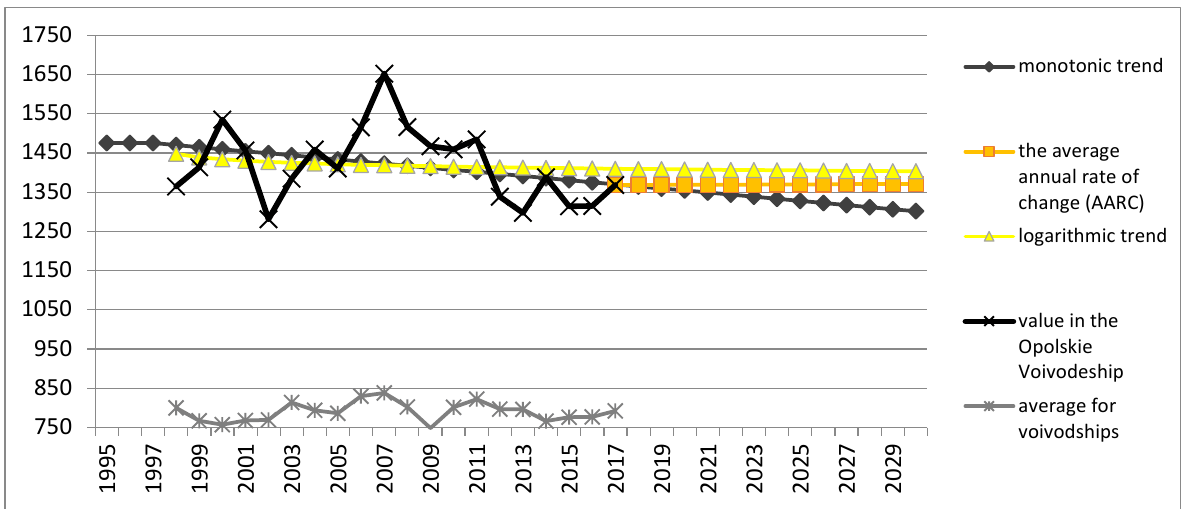
Figure 4. Gas pollutant emission from particularly troublesome plants, including CO 2 emission per km 2 of surface area (in tons per year per km 2 of surface area). Source: own elaboration. As a result of the impact of the aforementioned determinants, the lack of air quality improvement in relation to the PM10 content was maintained, i.e., the average daily PM10 pollution (in micrometres (one millionth of a metre) per cubic metre ( µ g/m 3 )) amounted to 32.60 in 2016 with a national average of 29.27, which means that the unfavourable trend was maintained. The forecasted value will amount to 31.37 in 2030 (Figure 5). Another aspect related to the key issue is the lack of any visible improvement in the surface water purity and an increase in the water consumption for national economy and population purposes per inhabitant (in hectometres per inhabitant). In 2017, the indicator amounted to 132.93 with a national average of 254.87. In 2030, the indicator will reach 160.44, thereby maintaining the unfavourable upward trend in water consumption in the